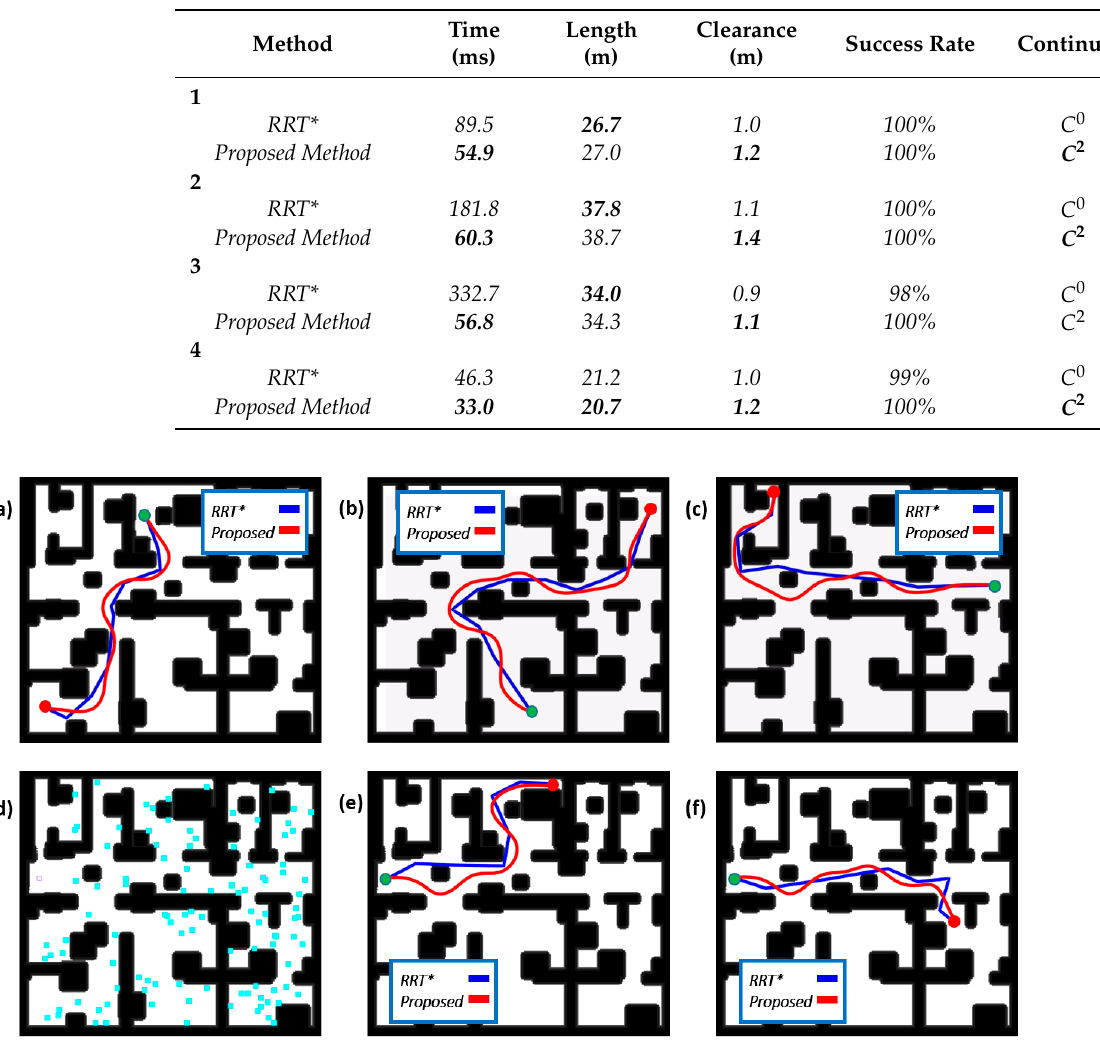
Figure 10. The performance of different path planning methods. A green dot represents the starting point, and a red dot represents the target point. ( a – c ) correspond to the performance of different methods in the first three sets of experiments. ( d – f ) correspond to the fourth set of experiments. ( d ) shows the randomly generated 100 valid target points. (e) and (f) show the performance of different methods of the two experiments.